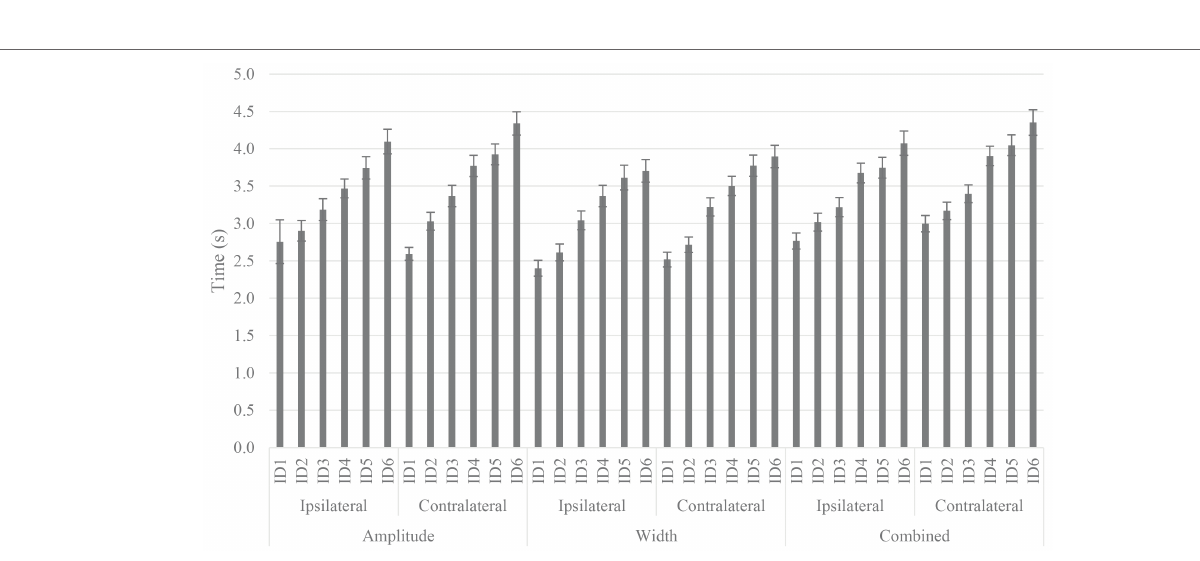
FIGURE 3 | HSCT completion time increased in each task, in each region of space, and in each condition. The covariates age, WHQ score, and the interaction between age and WHQ score were significant predictors of HSCT completion time. Standard error bars are displayed.